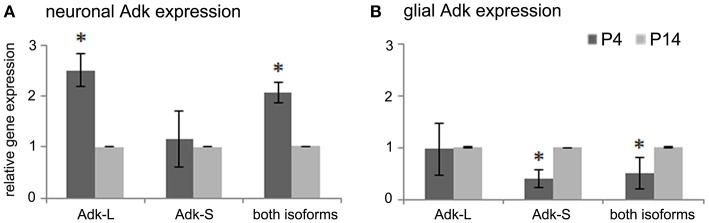
Adk gene expression in early postnatal brain development. (A) Adk gene expression of long and short Adk isoforms separately as well as total Adk expression in rat hippocampal neurons and (B) in rat hippocampal glial cells at postnatal days 4 and 14 (P4 and P14, respectively) is shown. Adk gene expression was calculated relative to internal reference gene GAPDH. Neuronal and glial Adk gene expression at P4 was normalized to respective expression at P14, which was always set at 100%. Adk-L - long Adk isoform; Adk-S - short Adk isoform. *indicates significance.